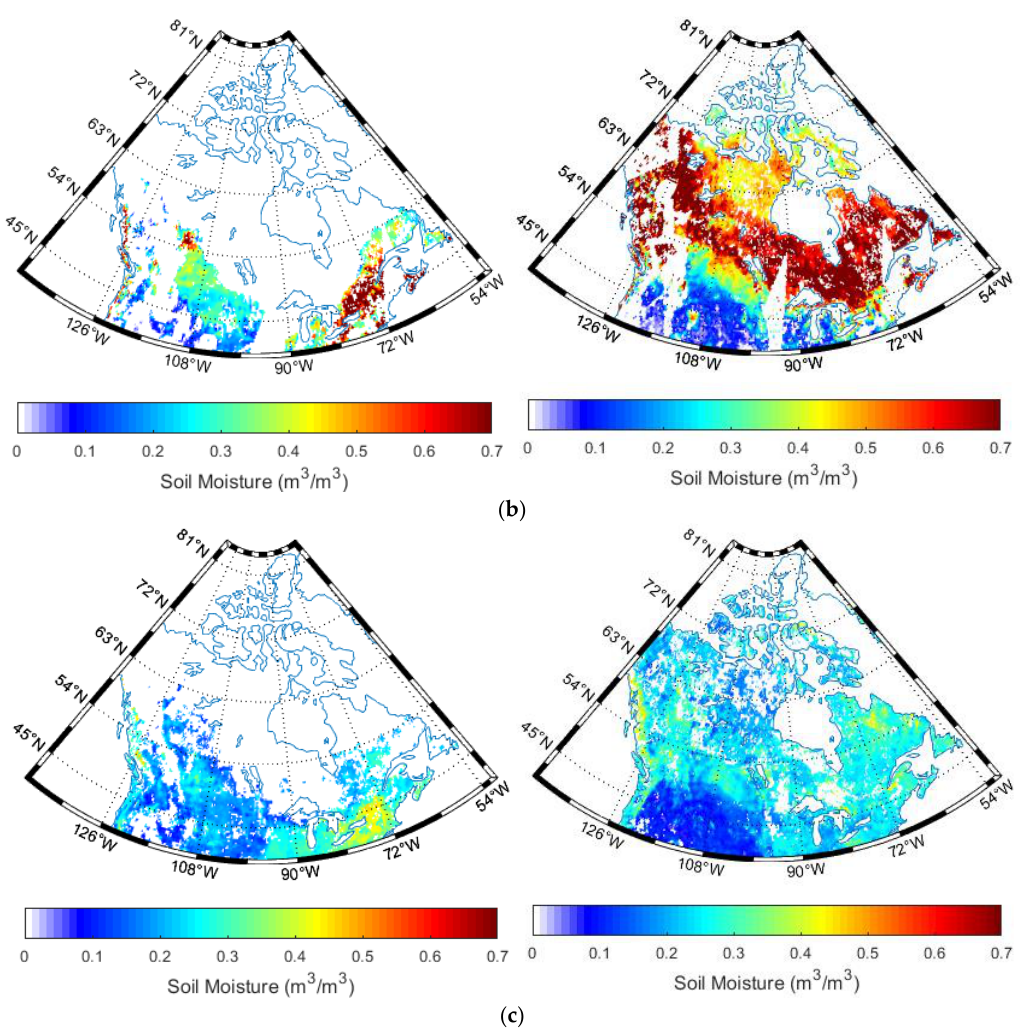
Figure 10. Extracted soil moisture retrieved from ( a ) active ( b ) passive ( c ) combined microwave data over Canada on 15 April (left) and 27 July (right) 2014.